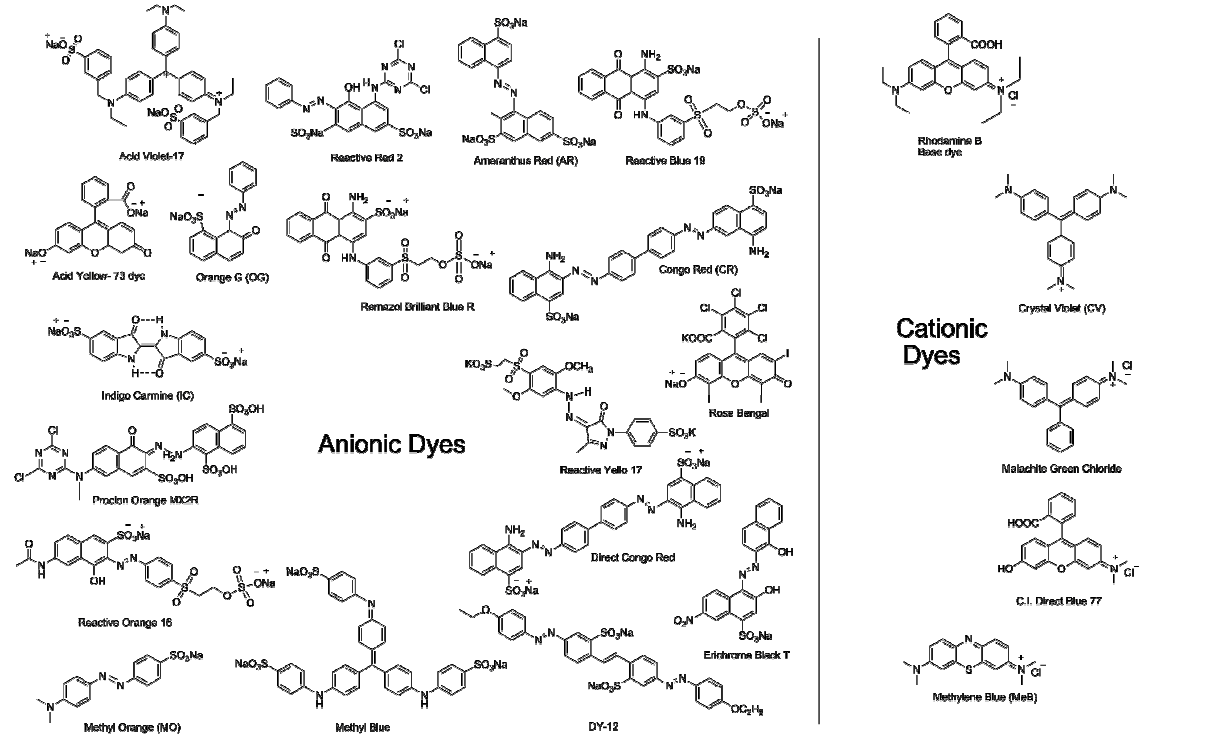
Figure 3. Structures of the anionic and cationic dyes.